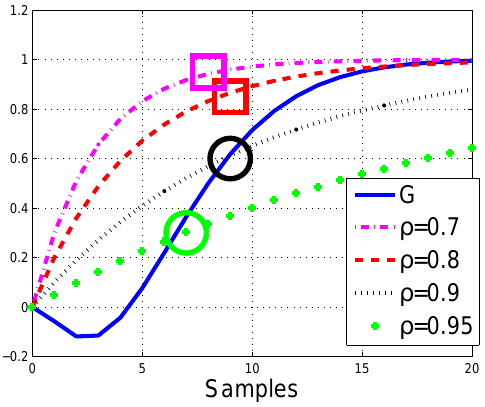
Figure 11. Open-loop step response of G coincidence points for a non-minimum phase